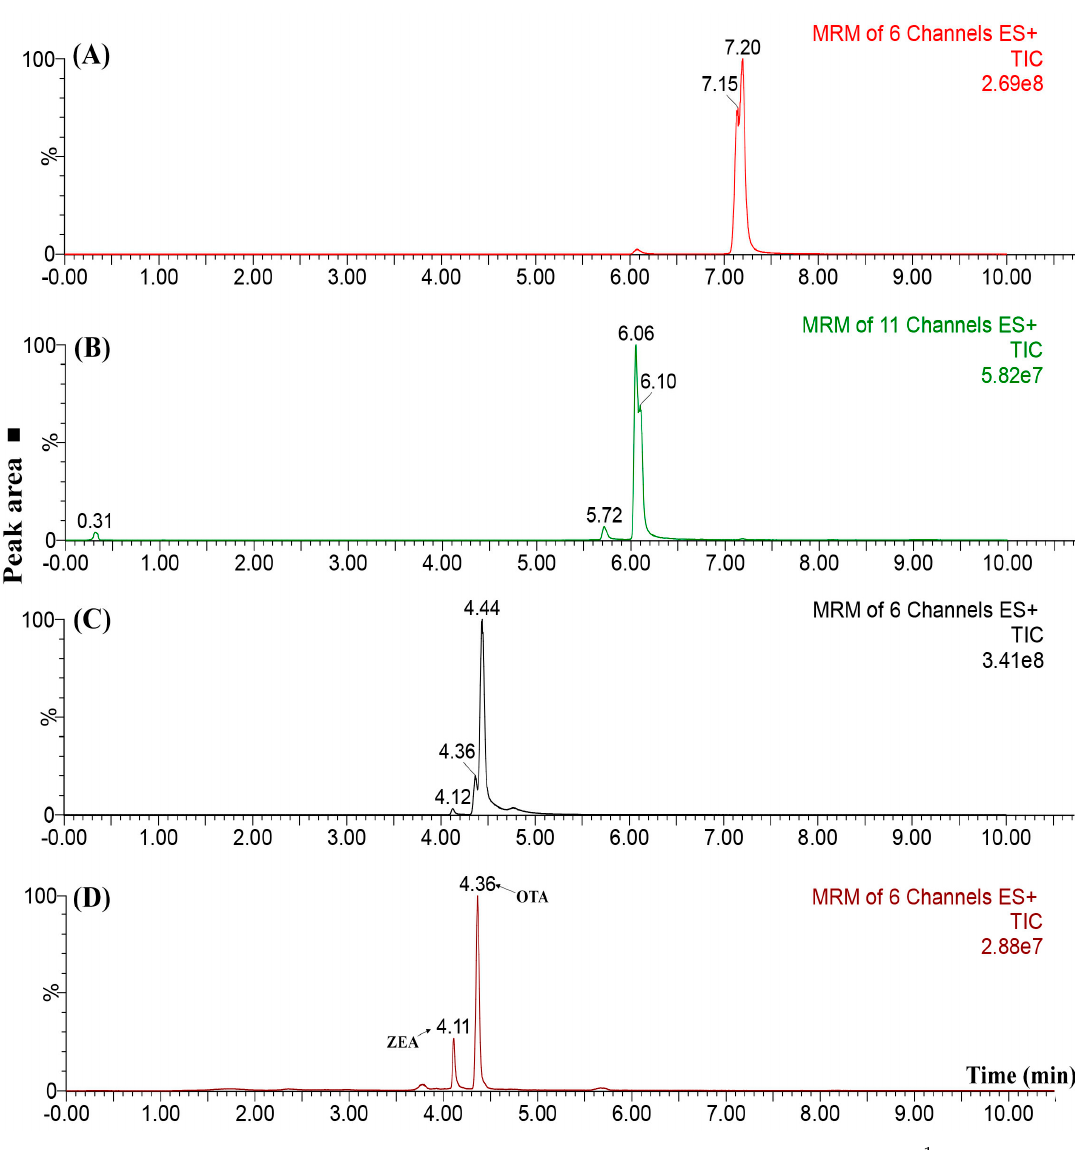
Figure 3. Chromatograms of a mixture containing OTA and ZEA (zearalenone) (15 µ g L − 1 ) aiming to achieve a satisfactory liquid chromatography separation. ( A ) Isocratic elution employing ACN:H 2 O (30:70, v / v ); ( B ) acidification with 0.1% formic acid into mobile phases and the employment of an elution gradient; ( C ) enhancing the flow rate from 8 to 10 µ L min − 1 and ( D ) enhanced condition by fixing the flow rate at 10 µ L min − 1 and performing a less-steeped elution gradient.